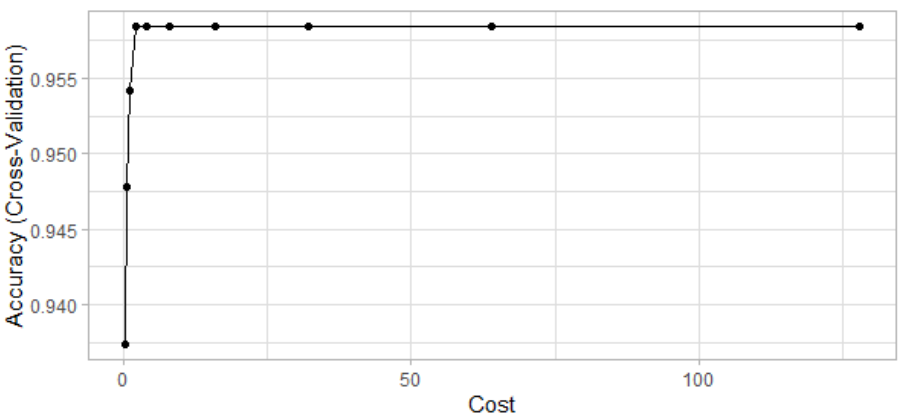
Figure 24. Selecting the cost parameter for the breast cancer